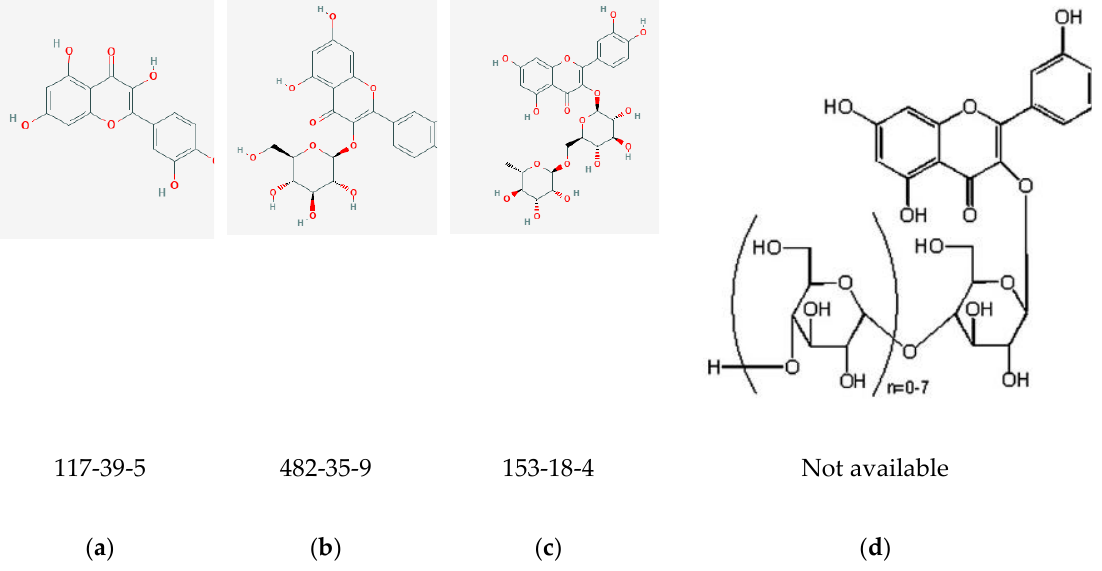
Figure2. ChemicalstructureswithCASRNs: ( a )quercetin[42]; ( b )Isoquercitrin(IQC)[43]; ( c )Rutin[44]; Figure 2. Chemical structures with CASRNs: ( a ) quercetin [42]; ( b ) Isoquercitrin (IQC) [43]; ( c ) Rutin ( d ) Enzymatically modified isoquercitrin (EMIQ) [44]; ( d ) Enzymatically modified isoquercitrin (EMIQ) [45].